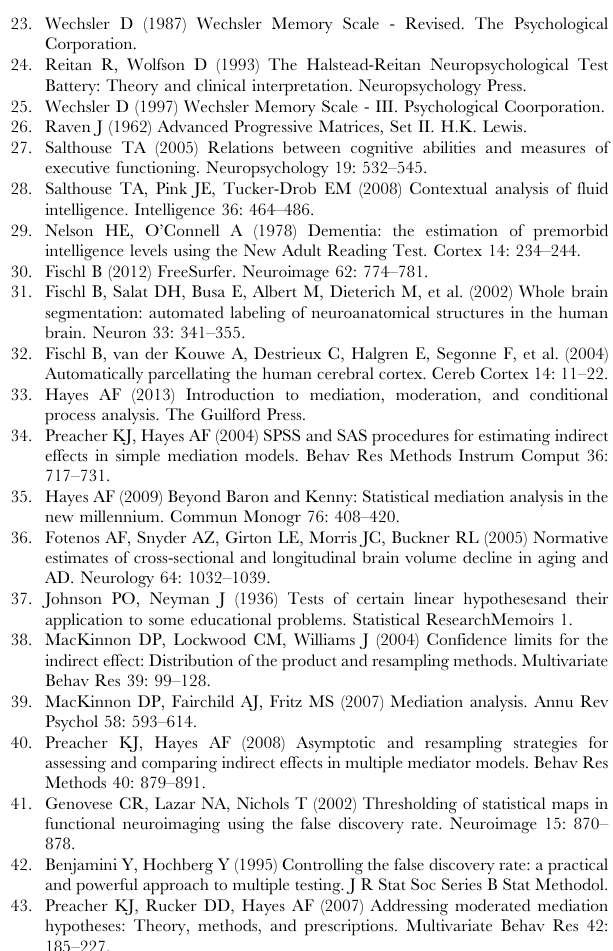
Table S3, Memory, Model B. Table S4, Memory, Model C. Table S5, Memory, Model D. Table S6, Speed, Model A. Table S7, Speed, Model B. Table S8, Speed, Model C. Table S9, Speed, Model D. Table S10, Fluid Ability, Model A. Table S11, Fluid Ability, Model B. Table S12, Fluid Ability, Model C. Table S13, Fluid Ability, Model